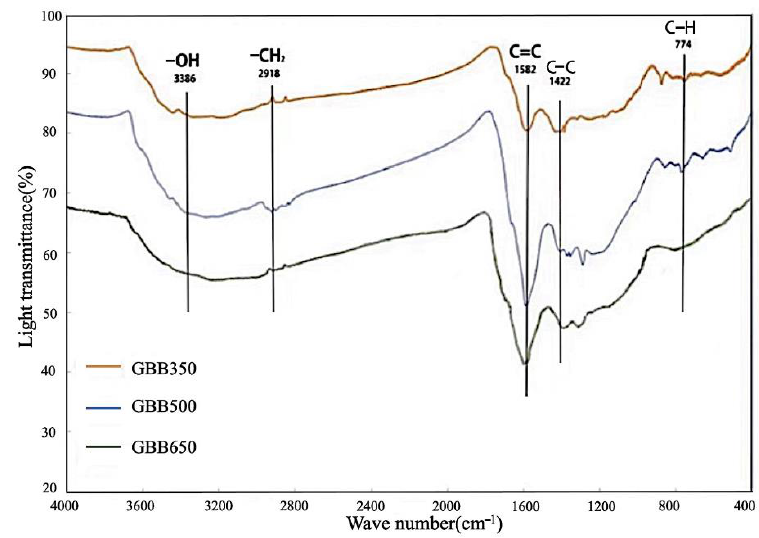
Figure 4. Infrared spectrum analysis of GBB at different temperatures.